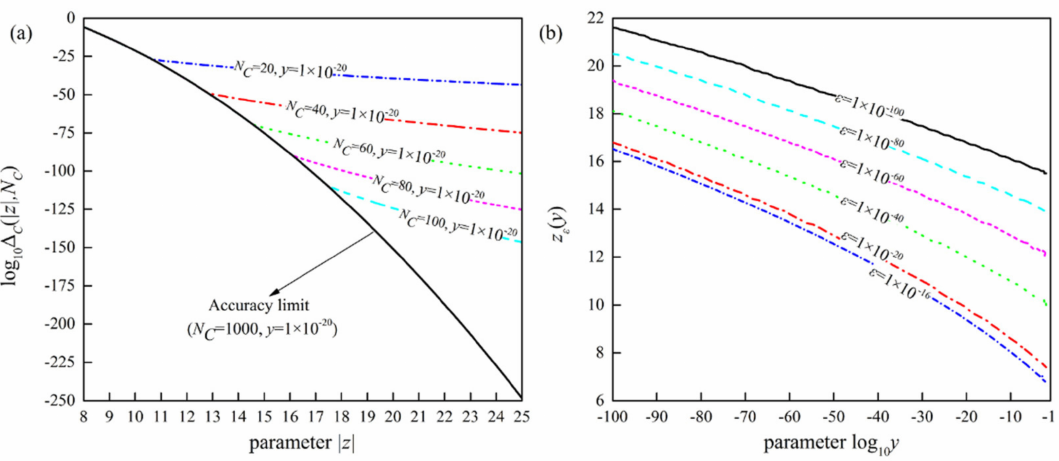
Figure 1. ( a ) The approximation accuracy of Equation (23) with y = 1 × 10 − 20 at different N C and ( b ) the efficient computing boundary z ε ( y ) with different selected